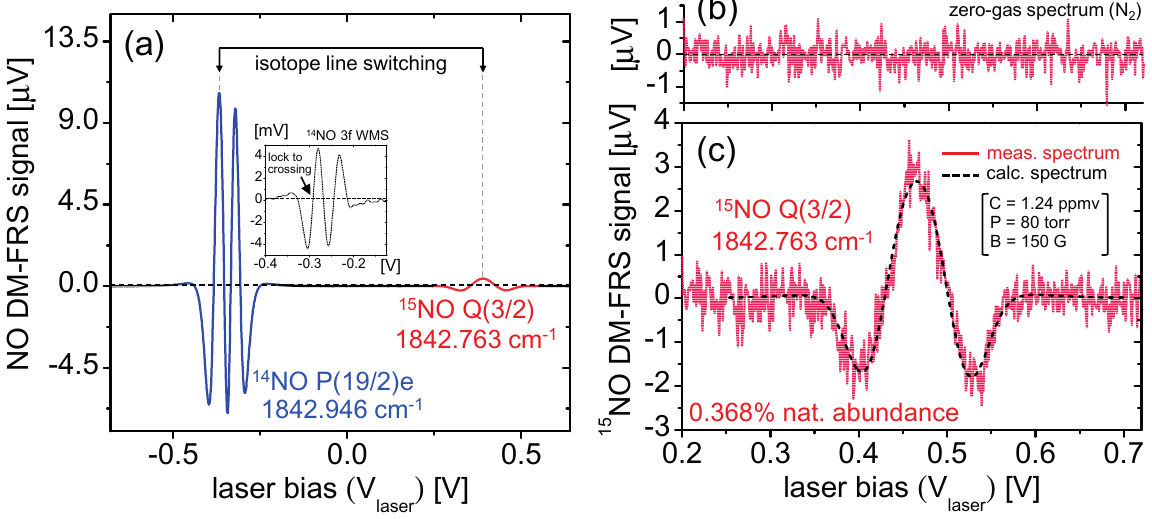
Figure 3. ( a ) Spectra of 14 NO P(19/2)e (blue) and 15 NO Q(3/2) (red) transitions from a G-Cal permeation device. Quasi-simultaneous isotopic analysis via line switching can be performed by alternately locking to the 3 f L WMS zero-crossing each isotope; ( b ) Zero-gas spectrum using cylinder nitrogen demonstrating near-zero baseline spectra; ( c ) Measurement of 15 NO spectra using non-certified NO in N 2 mixture. Spectral modeling gives 15 NO concentration of 4.56 ppbv, corresponding to 1.24 ppmv 14 NO at natural